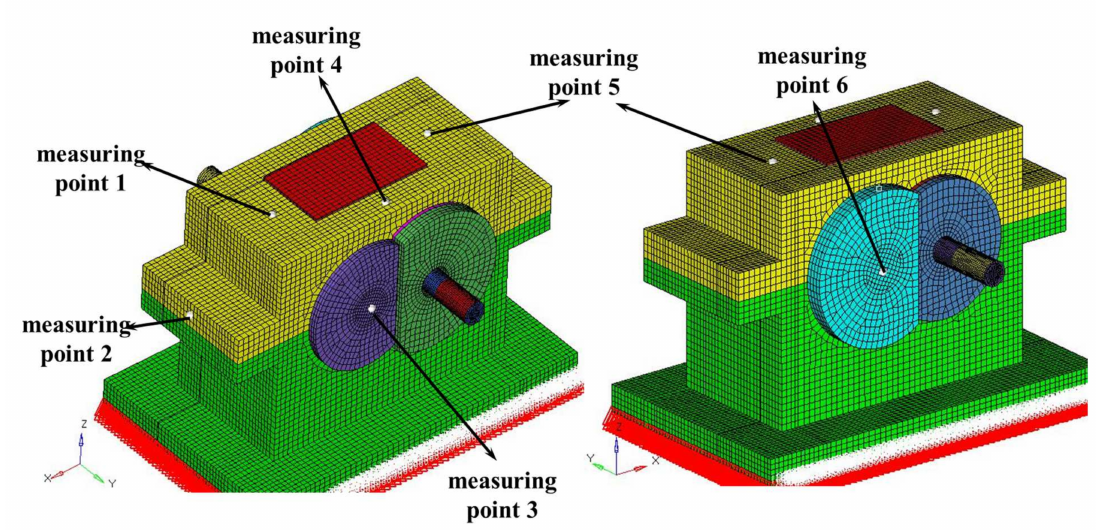
Figure 16. The measuring points on the surface of the